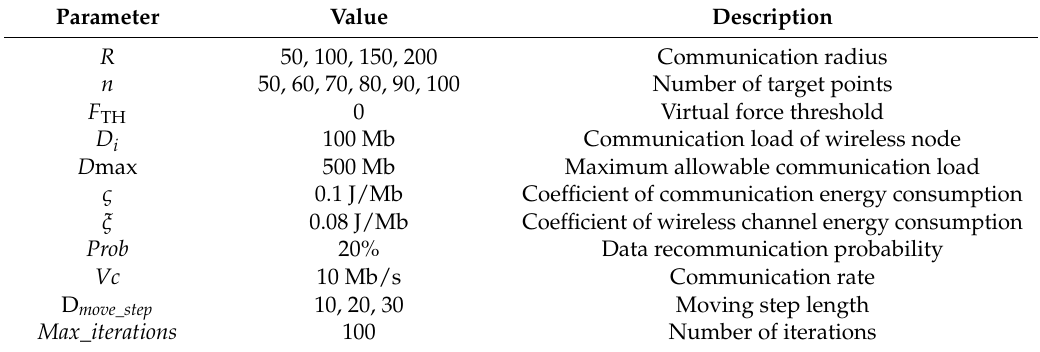
Table 1. Parameters values used in the simulation.